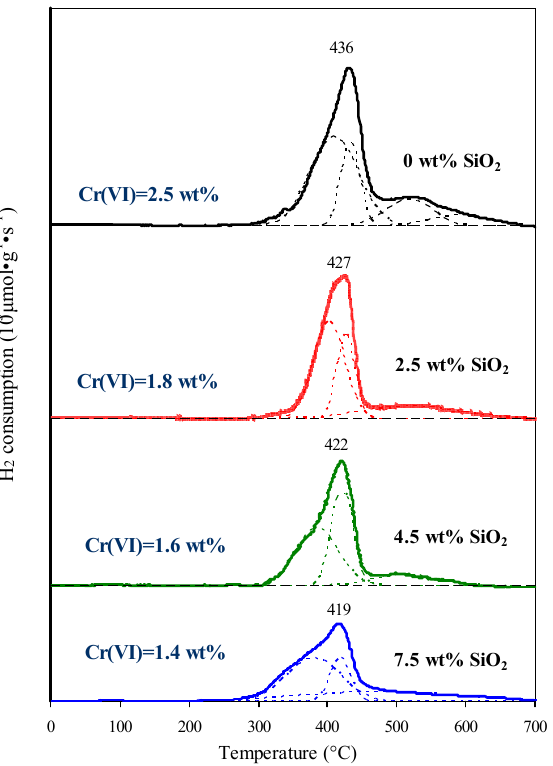
Figure 12. H 2 -temperature programmed reduction (TPR) profiles of Figure 12. H 2 ‐ temperature programmed reduction (TPR) profiles of catalysts.